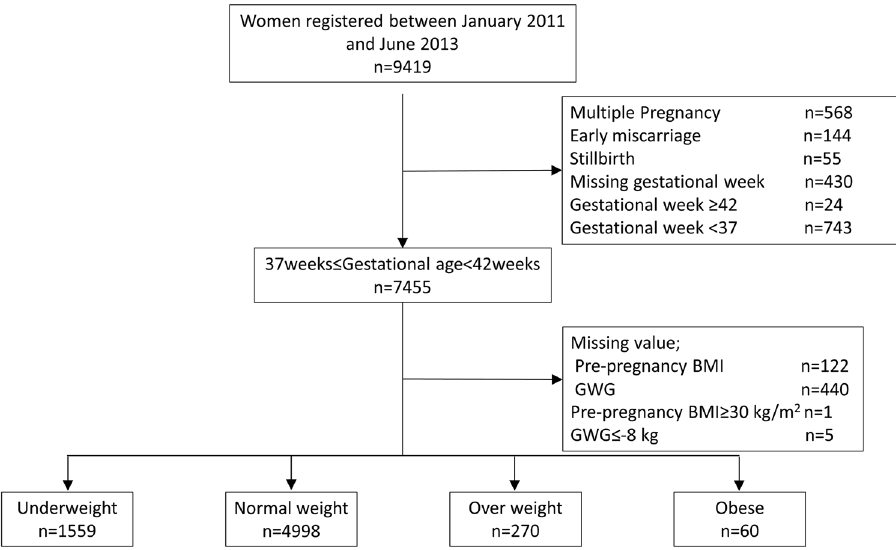
Figure 2. Title and Legend: Flowchart showing total number of participants enrolled and the final number of participants according to pre-pregnancy BMI categories included in the